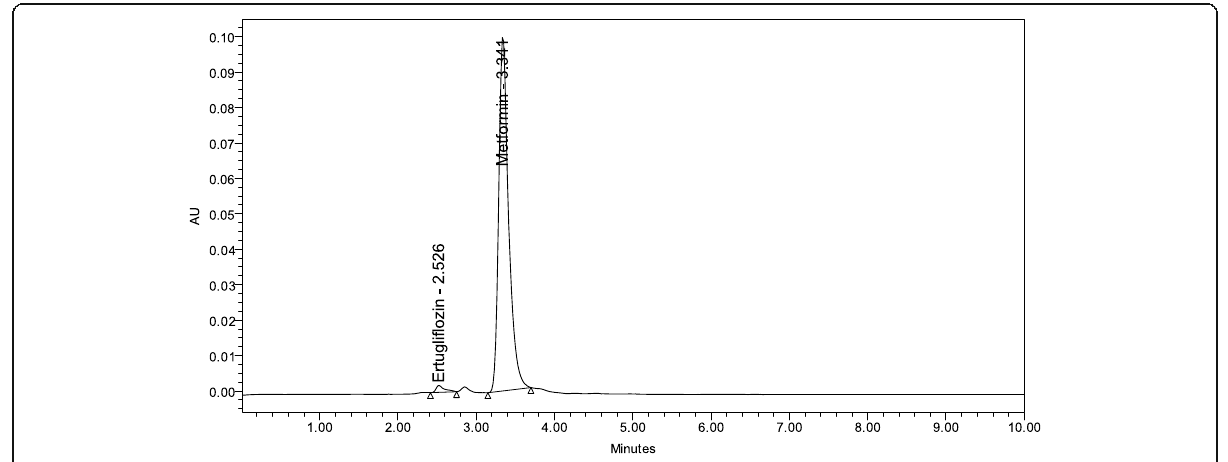
Fig. 8 Chromatogram of Ertugliflozin and Metformin subjected to peroxide degradation